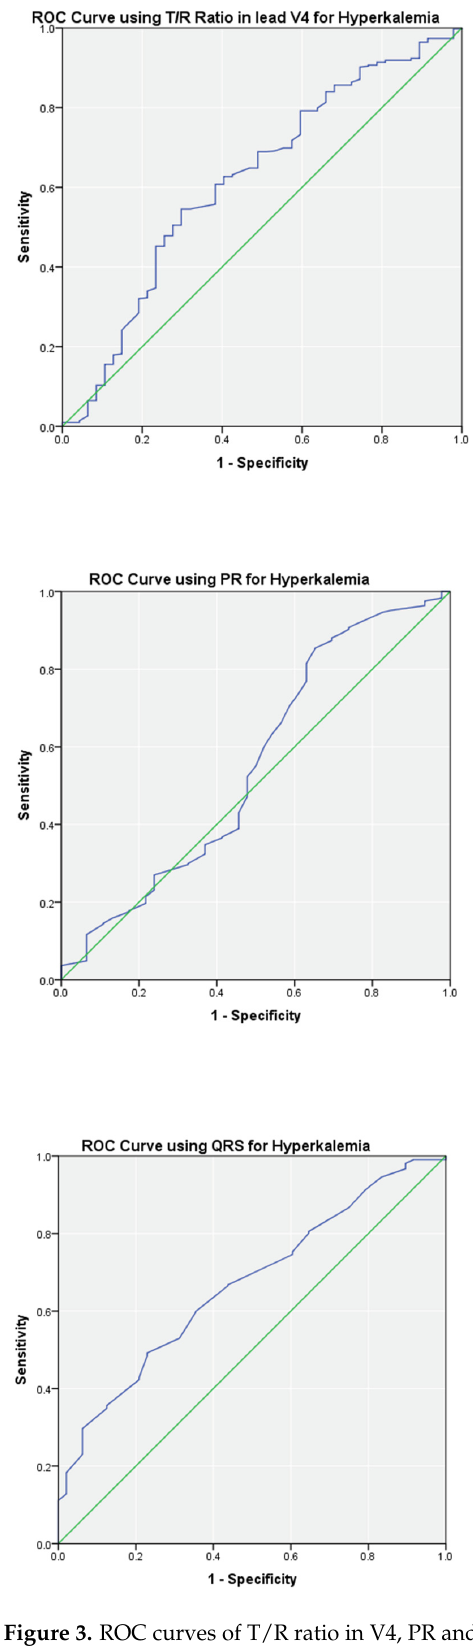
Figure 3. ROC curves of T/R ratio in V4, PR and QRS using the complete data set ( n = 476). The blue line shows the performance of ECG parameter. The green line is for